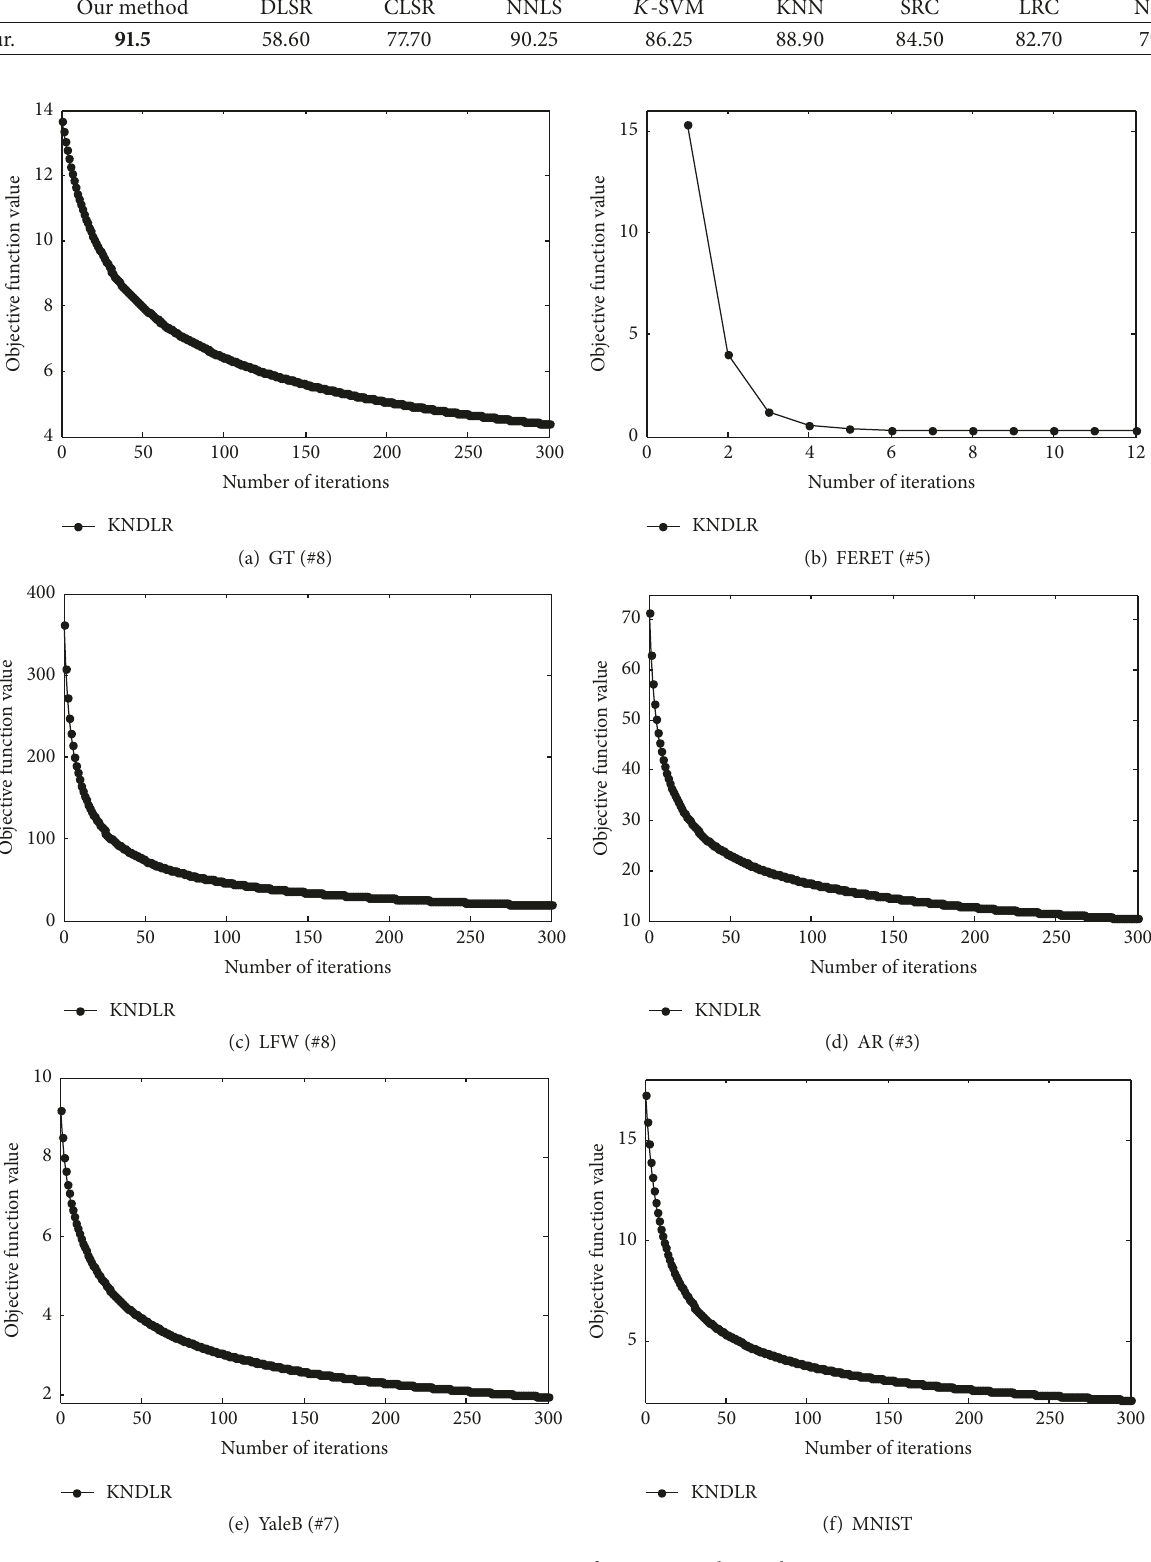
Table 6: Accuracies (%) of different methods on the MNIST database. Alg.